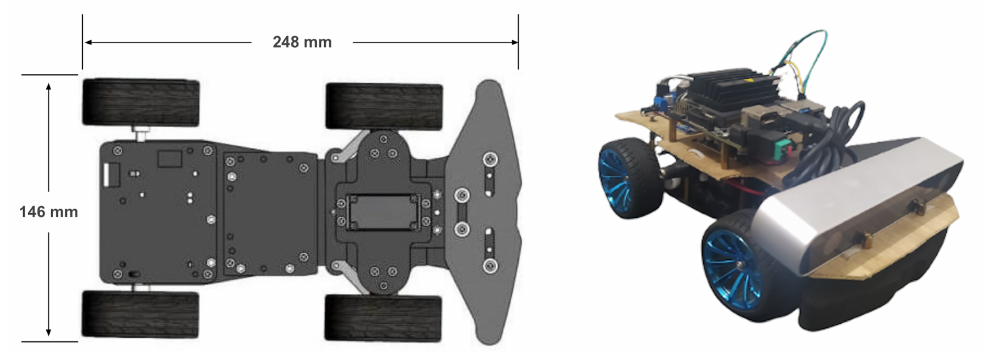
Figure 9. Scale prototype designed for self-driving physical